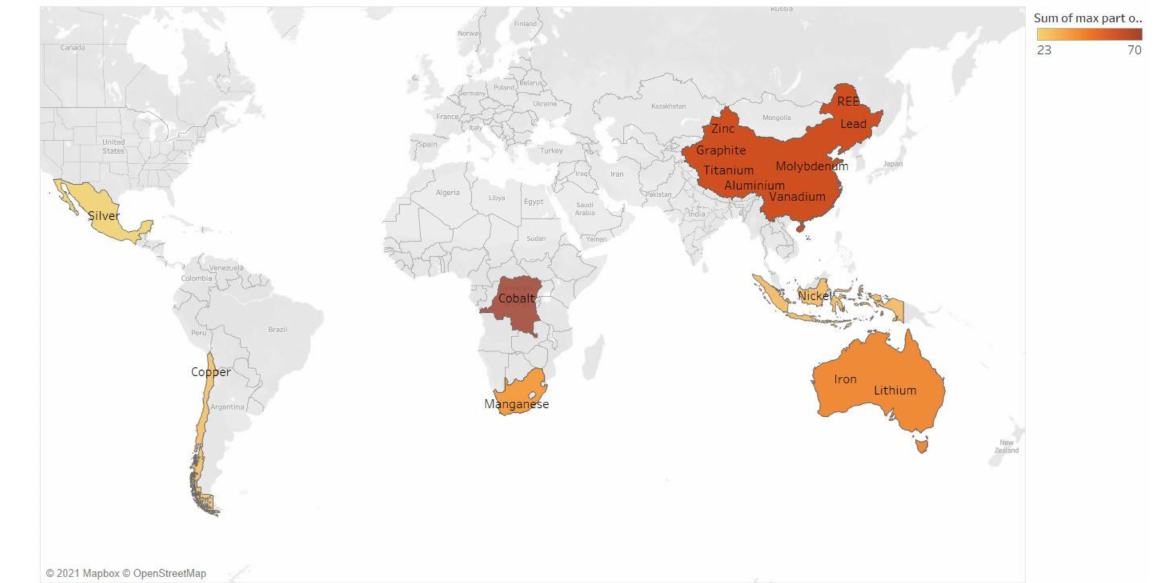
Table A1), which forced us to exclude one index in formula (5) or replace values of Reserves AI with 1.0. Certainly, this shifted the final integral estimation described below.